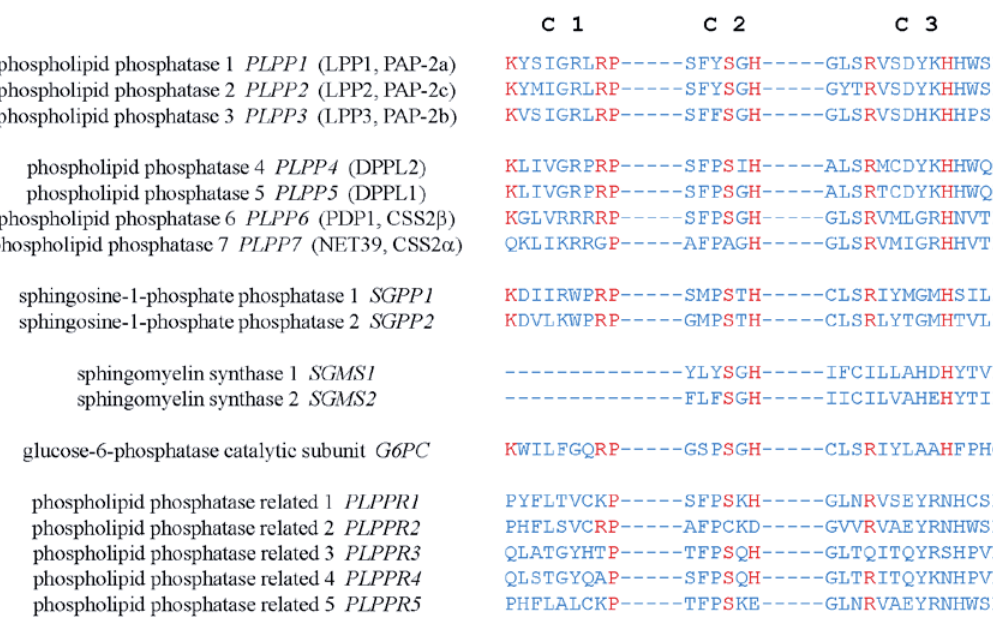
Figure 2. Amino acid sequences of the conserved catalytic domains, C1, C2, and C3, in human LPPs and other proteins with structure similarity. Residues critical for the catalytic activity are shown in red.